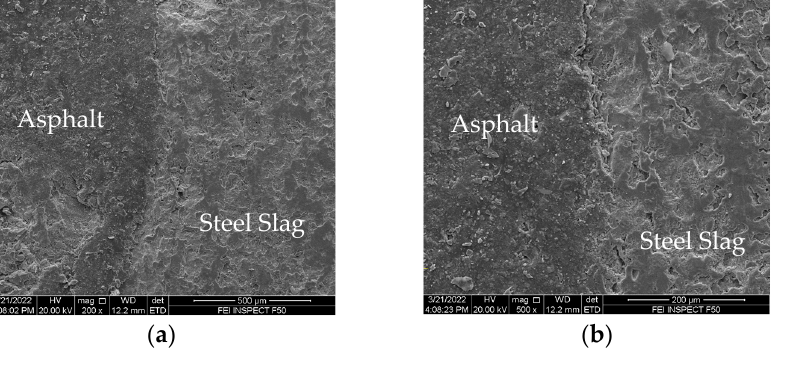
Figure 10. Asphalt-binder and steel slag interfacial imaging results: ( a ) ×200 magnification; ( b ) ×500 magnification; ( c ) ×1000 magnification.